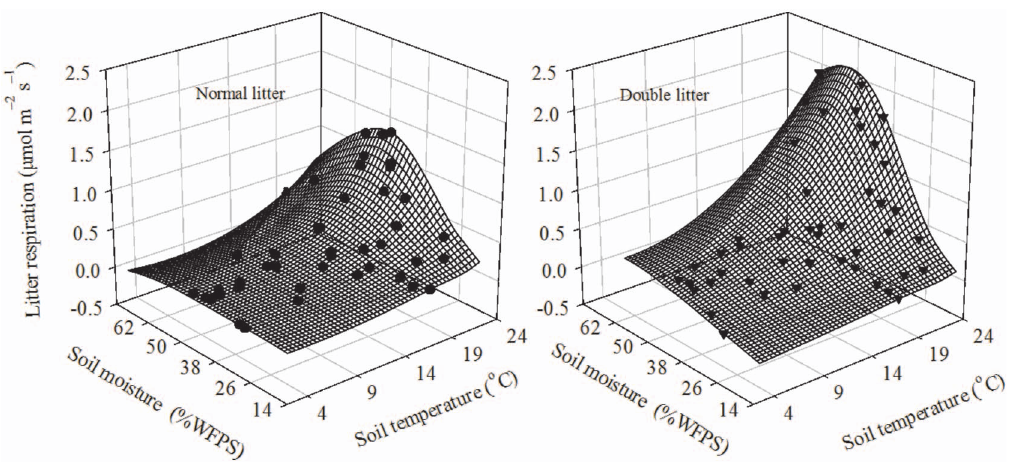
Figure 6. Response surface of litter respiration with normal and double litter treatments as a function of soil moisture and soil temperature from 2010 to 2012.